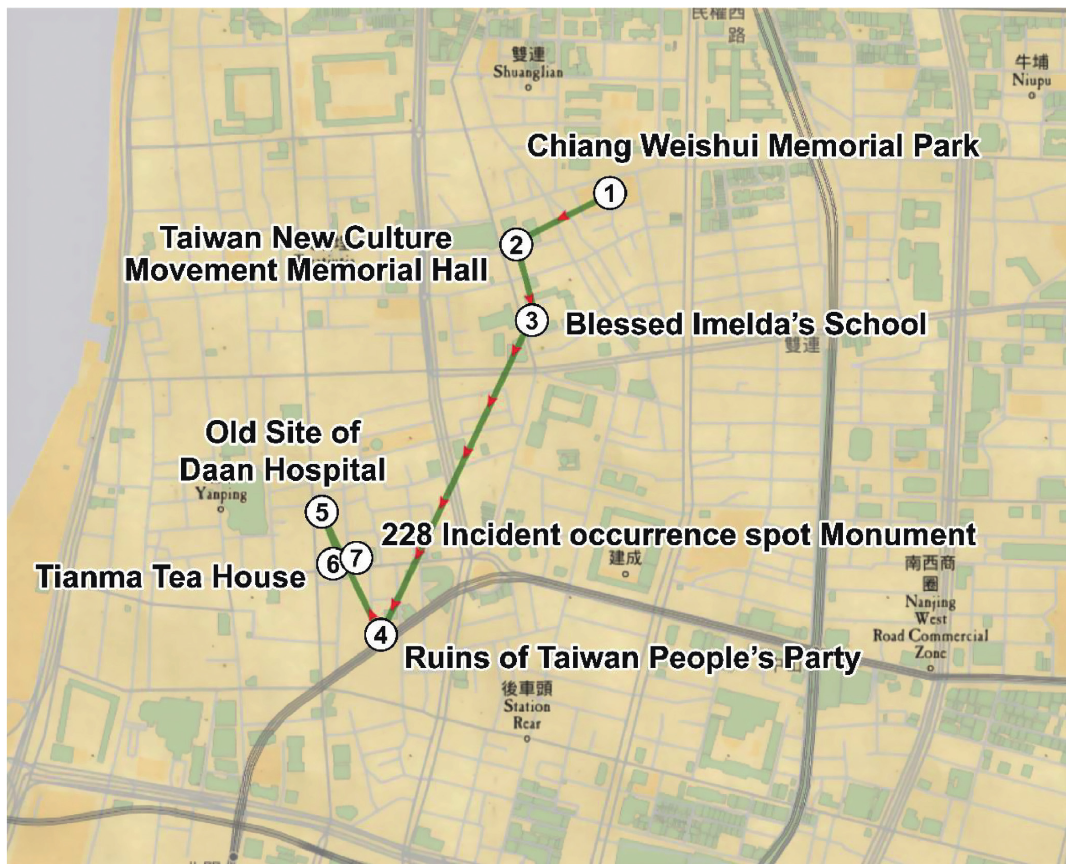
Figure 2: Taipei freedom route